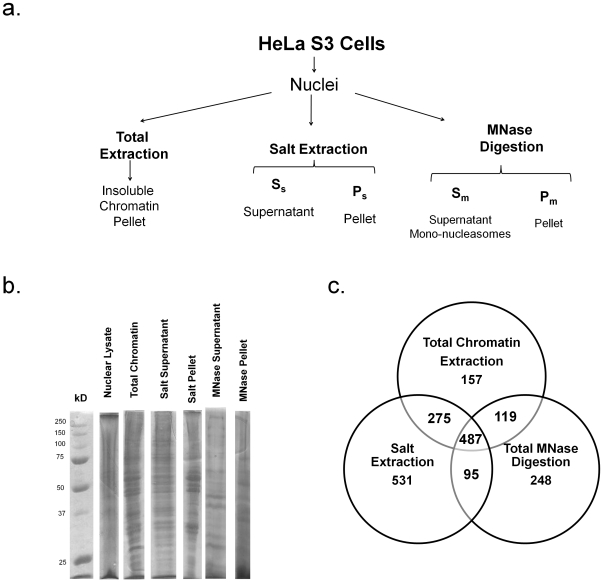
Comparison between chromatin purification methods.(a.) Chromatin was purified from HeLa cells through three different preparations. (b.) SDS-PAGE analysis of a crude nuclear lysate and the chromatin preparations. Approximately 10 ug of protein were loaded in each lane. Supernatant and pellet fractions are shown separately for the salt extraction and the MNase digestion protocols. (c.) Venn Diagram indicating the number of proteins detected in one, two or all three chromatin preparations. Where applicable, preparation fractions (supernatant and pellet) were combined.